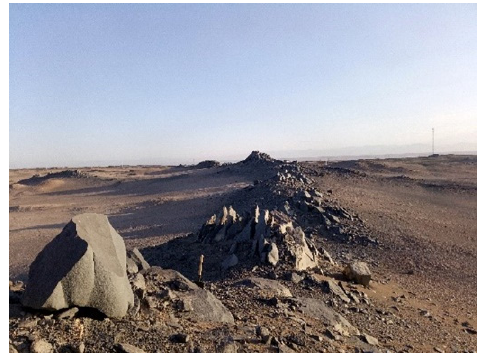
Figure 9. Intermediate rocks are distributed in the diorite area as veins.